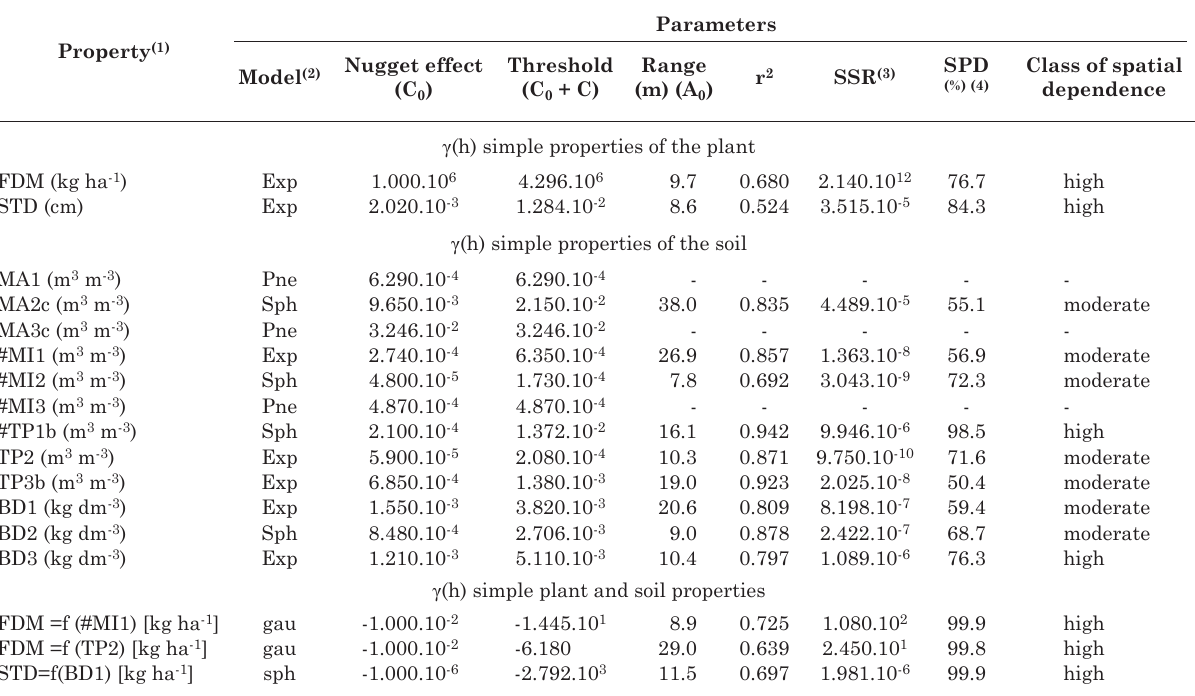
table 2. parameters of the semivariograms adjusted to some properties of corn forage yield and soil physical properties of a dystrophic red latosol